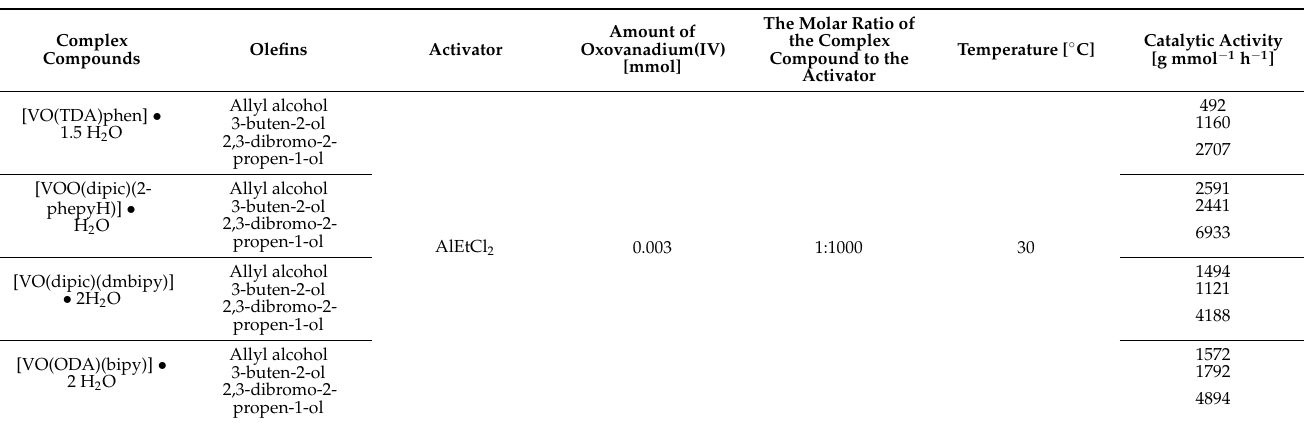
Table 7. Influence of coordination complexes based on oxovanadium(IV) on catalytic activity in oligomerization reactions of allyl alcohol, 3-buten-2-ol and 2,3-dibromo-2-propen-1-ol. Complex